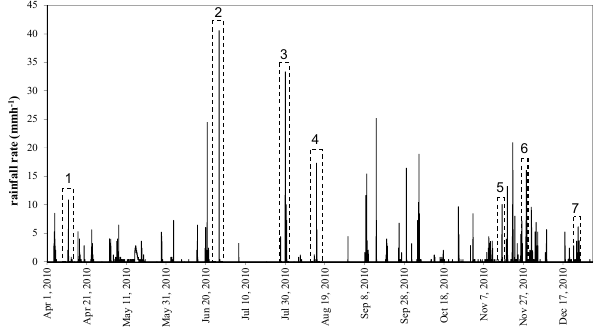
Fig. 2. Rainfall rate as a function of time observed in the study plot. Figure 2. Rainfall rate as a function of time observed in the study plot. The events used as 13 The events used as representative cases in this study are indicated representative cases in this study are indicated by the numbered dashed lines. 14 by the numbered dashed